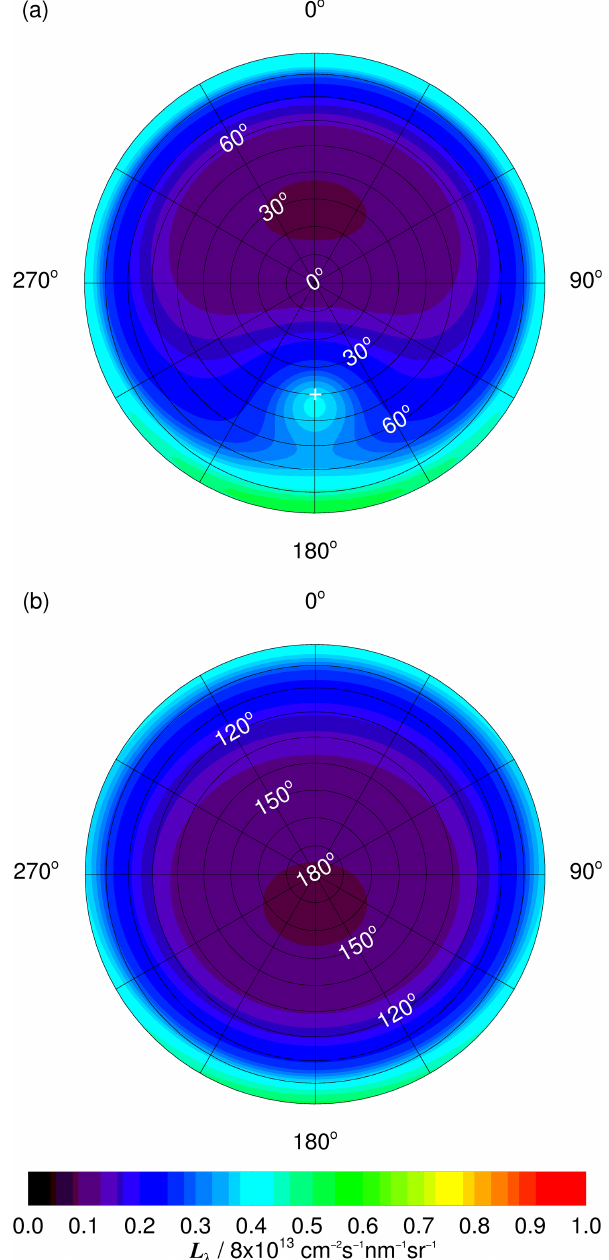
Figure 8. Contour plots of modelled diffuse spectral radiance dis- tributions for a wavelength of 400nm at an altitude of 5km un- der clear-sky conditions at solar zenith and azimuth angles of 40 and 180 ◦ , respectively. (a) Downward spectral radiance. (b) Up- ward spectral radiance. Polar angles (white) are defined as angles of incidence. The position of the sun is indicated by the white cross in panel (a) . In this example, ground albedos were scaled to 0.04 at 470nm and aerosol optical depths to 0.2 at 550nm (standard conditions). The colour scale was chosen for better comparability with Fig. S17, where the effects of an underlying As cloud layer are shown.